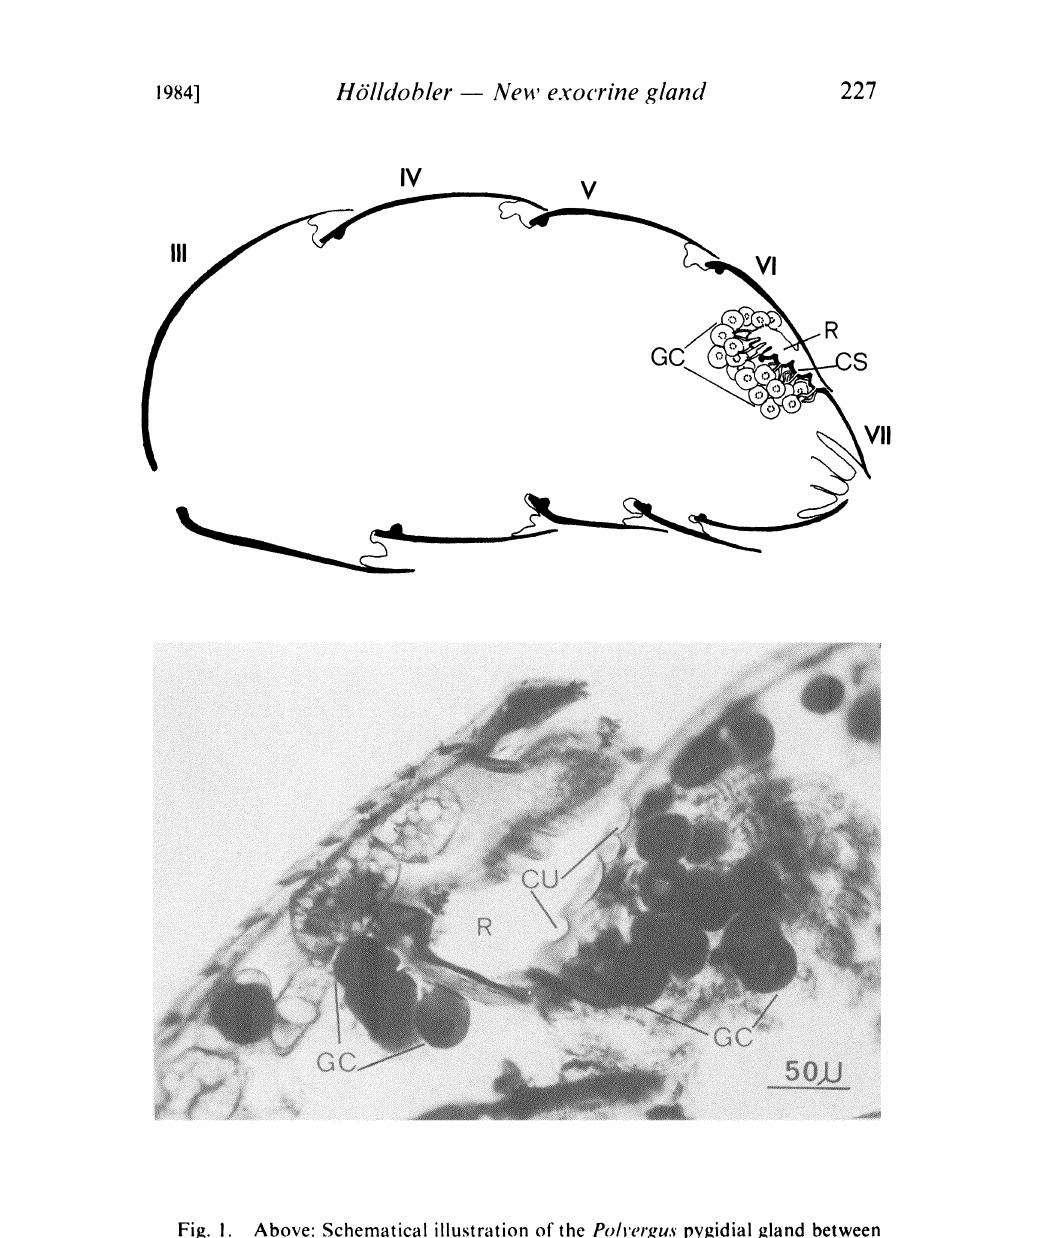
Fig. I. Above: Schematical illustration of the Pol.vergus pygidial gland between 6th and 7th abdominal tergites. Below: Longitudinal section through the pygidial gland of a P. rufescens worker. CS: cup structure; CU: cup; GC: glandular cells; R: intersegmental